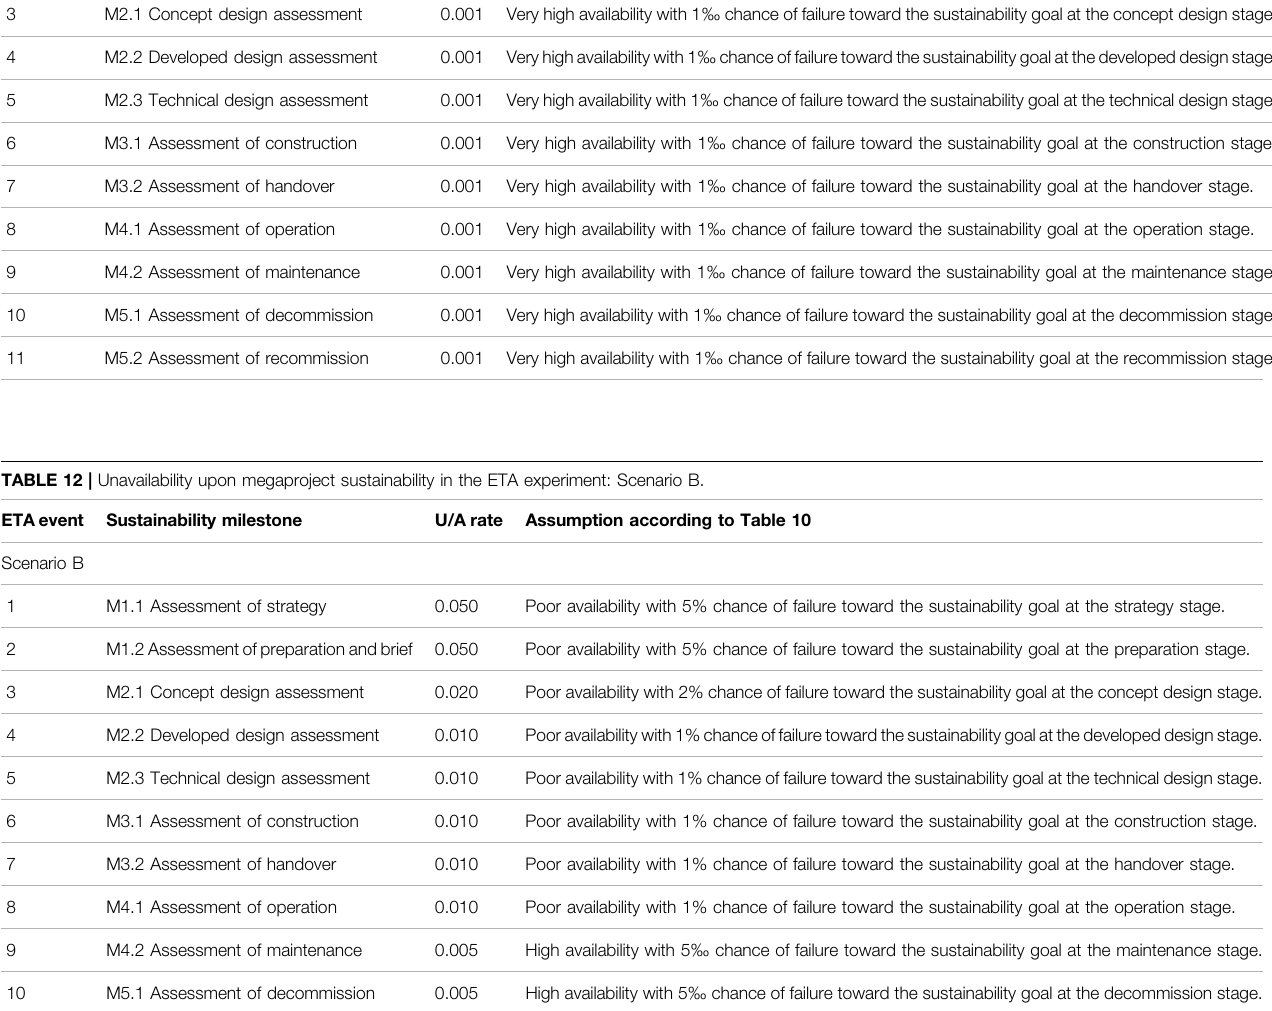
Assumption according to Table 10 rate